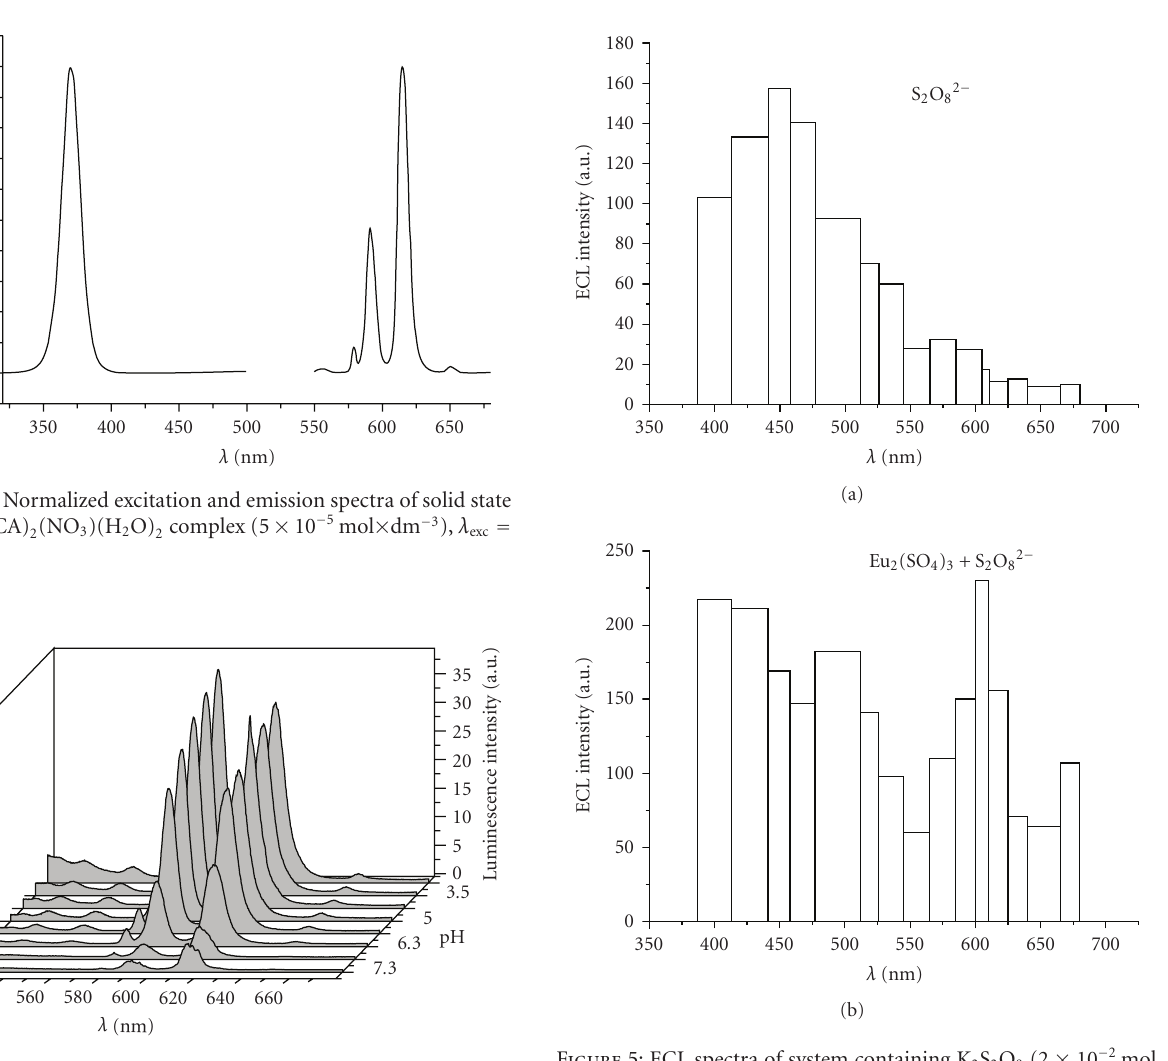
Figure 4: Photoluminescence spectrum of aqueous solution of (5 × 10 − 5 mol × dm − 3 ), λ exc = 355 nm as a function of pH.